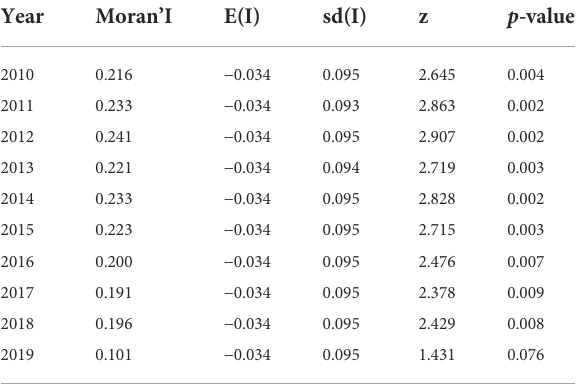
TABLE 3 Global Moran ’ I of carbon emission ef fi ciency of 30 provinces in China from 2010 to